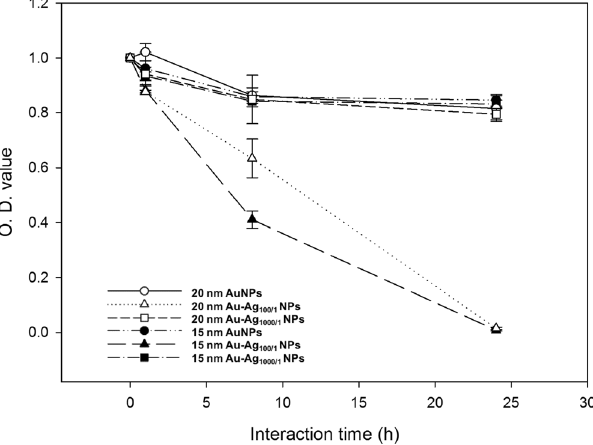
Figure 6. The survival curve of E . coli exposed to Au and Au-Ag NPs. E . coli were continuously exposed to different NP-coated cellulose paper for 24 h. The data is plotted as the percentage of surviving cells compared to the untreated controls (n =